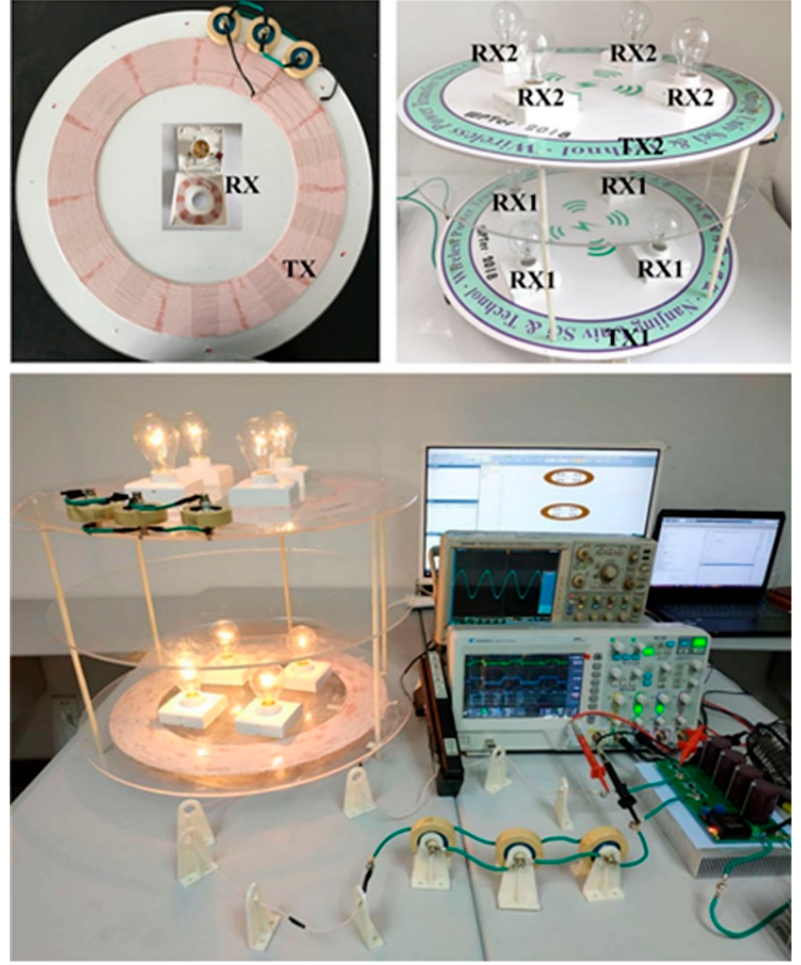
Figure 12. Experimental prototype, including high frequency power supply, TX and RX. When h = 37 cm and m = n = 3, the currents in the TX1, TX2, RX1 and RX2 loops would theoretically be 0.415 A, 0.415 A, 1.632 A and 1.632 A, respectively. When h = 32.2 cm and m = n = 4, the currents in TX1, TX2, RX1 and RX2 loops were anticipated to be 0.317 A, 0.317 A, 1.247 A and 1.247 A, respectively. Due to the harsher conditions considered in the simulation ( U S increased to 100 V), the system electromagnetic environment was further improved in the experiment.